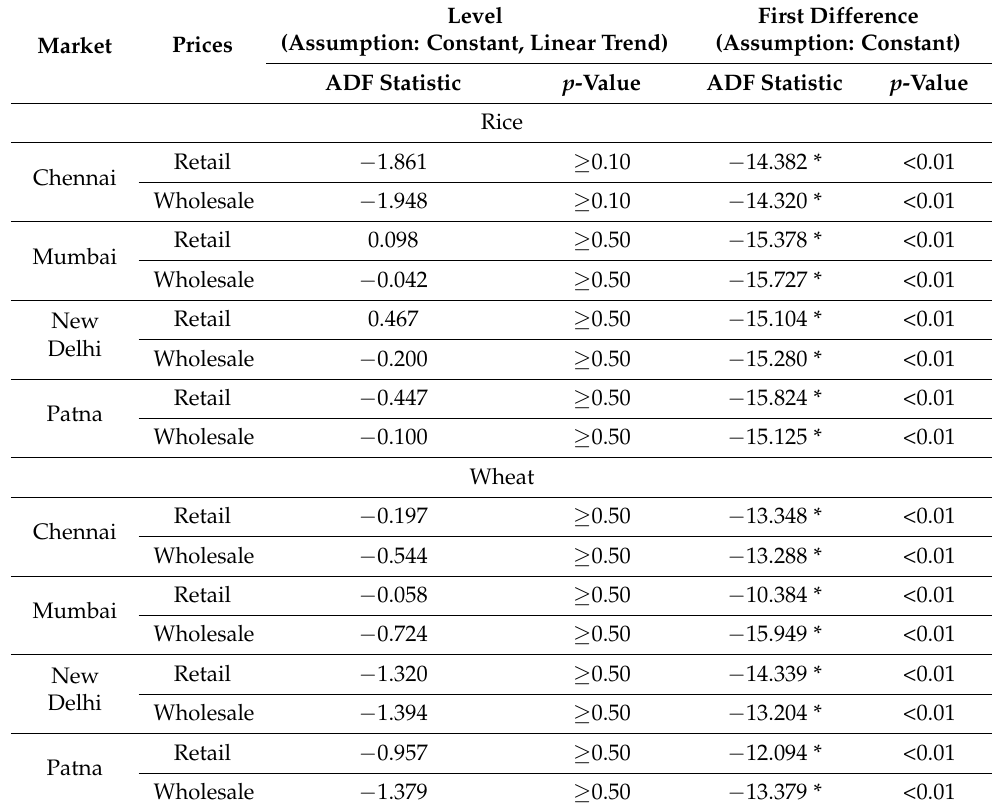
Table 5. Estimates of unit root test for the monthly prices of rice and wheat markets with structural break.